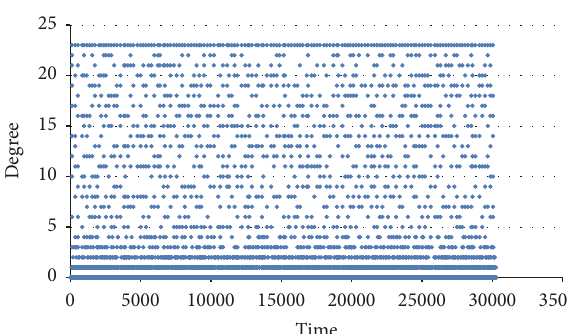
Figure 11: Degree of node 4 (developing project management plan), throughout the